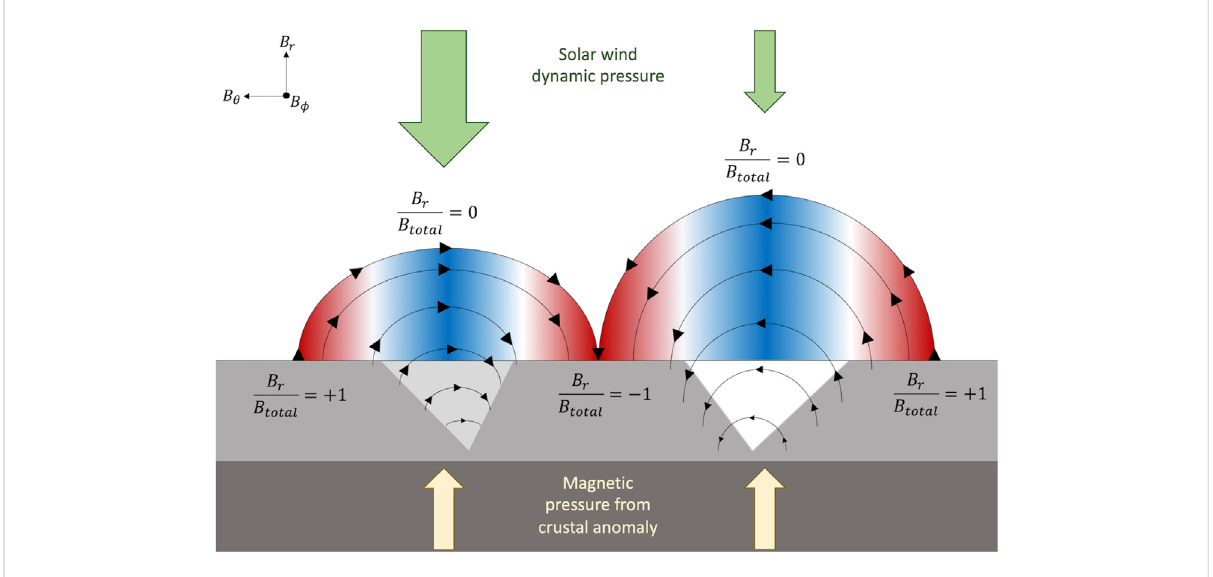
FIGURE 8 When the magnetic pressure from the source is less than the solar wind dynamic pressure, the anomaly is maximally compressed (left) and the regolith below experiences more weathering, similar to that at a non-magnetic background area, thus the bright portion of the swirl could become less apparent over time. When the magnetic pressure is equal to or greater than the solar wind dynamic pressure, the anomaly is minimally compressed(right)andtheregolithbelowexperienceslessweathering,thusthebrightregioncouldbecomemoreapparentovertimebecause of a greater contrast in weathering compared with the background. In both cases, the fi eld geometry is preserved at normal incidence angles to sustain maximum de fl ection of solar wind